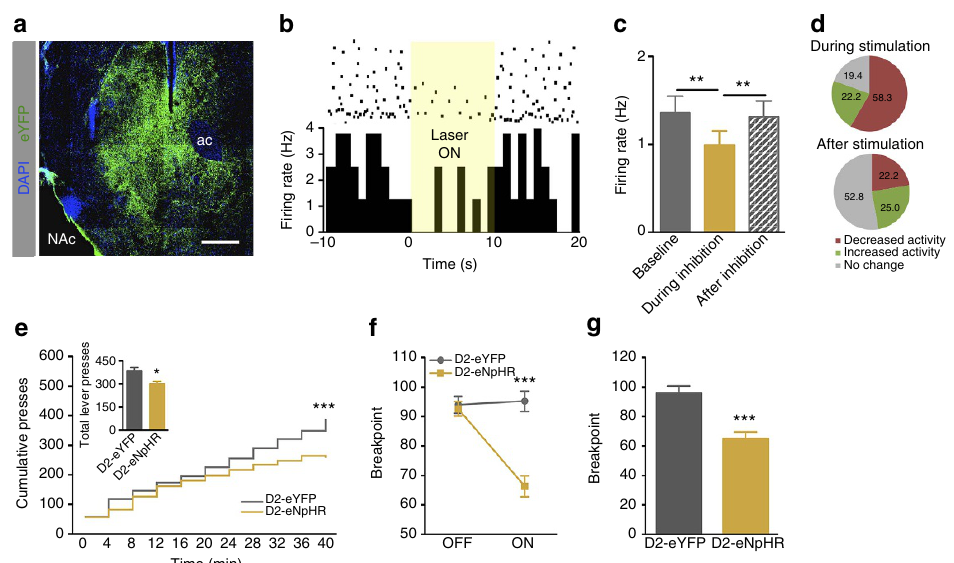
Figure 5 | Inhibition of NAc D2 neurons - electrophysiological and behavioural correlates. ( a ) Representative immunofluorescence against YFP in the NAc of an animal injected with AAV5-D2-eNpHR-eYFP. Scale bar: 400 m m; ac: anterior commissure. ( b - c ) Optogenetic stimulation of D2-eNpHR (10s constant light at 15 mW) decreases NAc firing rate ( n ¼ 20 cells). ( d ) During stimulation, 58.3% of cells decrease their firing rate, whereas 22.2% of cells increase their activity and 19.4% do not respond. After the stimulation (period of 60s), 52.8% of cells return to their basal activity levels, 22.2% of cells present decreased firing rate, and 25% of cells present increased activity. ( e ) Optogenetic inhibition of D2 neurons during cue exposure (15mWconstant light during 10s) decreases cumulative presses and breakpoint ( f , g ) in the PR test (n D2-ChR2 ¼ 8; n D2-eYFP ¼ 5). Error bars denote s.e.m. ** P r 0.01, *** P r